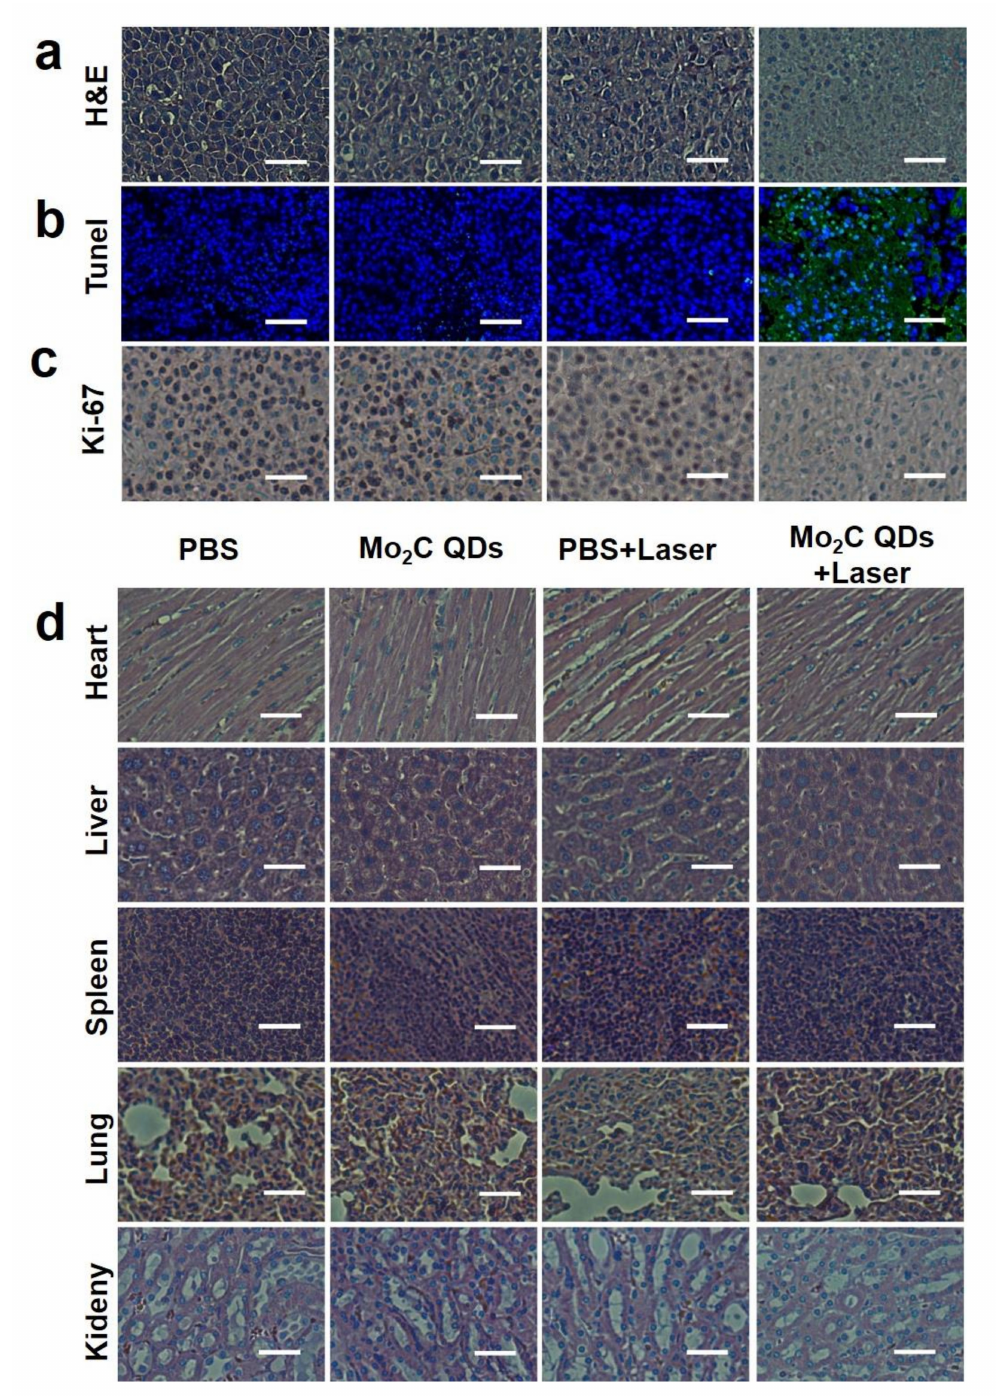
Figure 6. ( a ) Hematoxylin and eosin (H&E); ( b ) Antigen Ki-67 immunofluorescence and ( c ) terminal deoxynucleotidyl transferased UTP (Uridine triphosphate) nick end labeling (TUNEL) staining for pathological changes in tumor tissues from different groups after therapy; ( d ) H&E staining of major organs of each group. All the scale bars are 66 µ